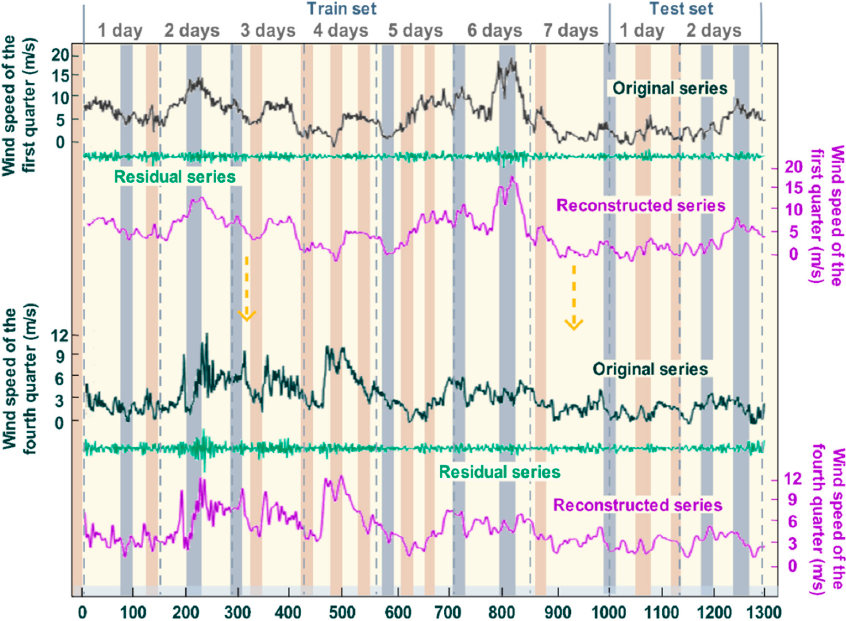
Figure 5. The results of the wind series of Unit 12 (10 min) disposed by SSA. Table 2. The experiment parameters of BP.